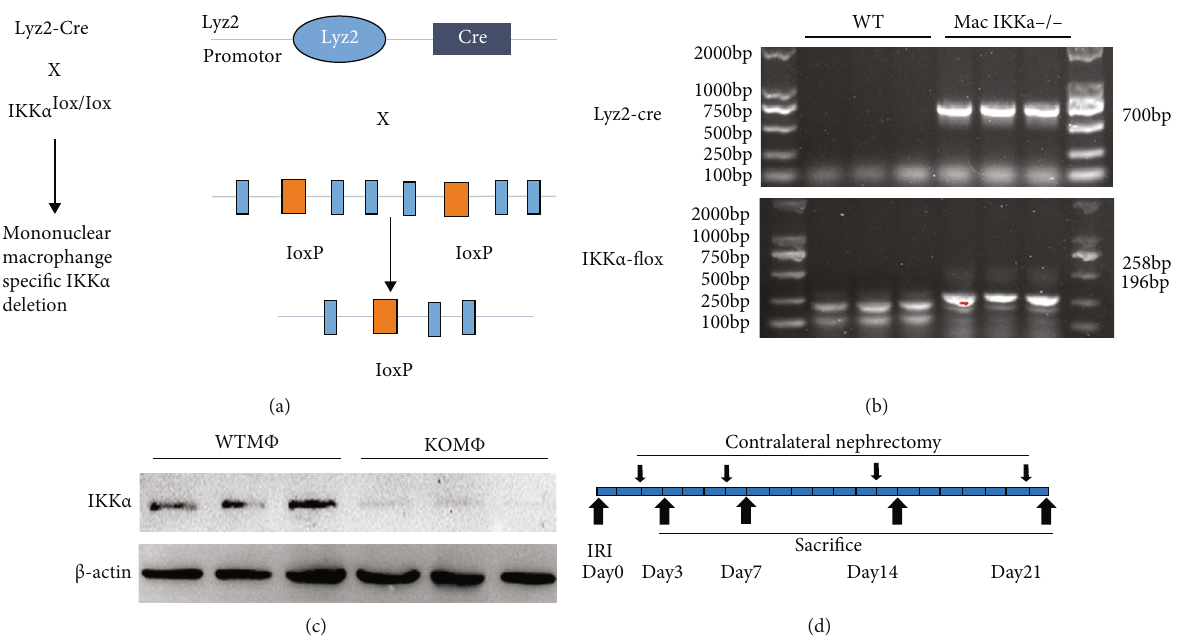
Figure 1: Generation of mice with the IKK α gene macrophage-speci fi c ablation and the strategy for the mouse experiment. (a) The strategy of cross-breeding of the IKK α - fl oxed mice (IKK α fl / fl ) with Cre transgenic mice under the control of a lyz2 promoter (lyz2-Cre). Black boxes indicate the exons of the IKK α gene. Orange boxes denote the LoxP sites. (b) PCR analysis for the identi fi cation of the genotype of the mice. Lanes 1 – 3 show the genotyping of the WT mice, while lanes 4 – 6 indicate the genotypes of Mac IKK α − / − mice. (c) Western blotting demonstrated a signi fi cantly reduction in the IKK α protein of macrophages isolated from Mac IKK α − / − mice compared with WT mice after isolation by thioglycollate broth. (d) Strategy for inducing kidney AKI-to-CKD transition: WT and Mac IKK α − / − mice were sacri fi ced at day 3, day 7, day 14, and day 21 after being subjected to renal IR